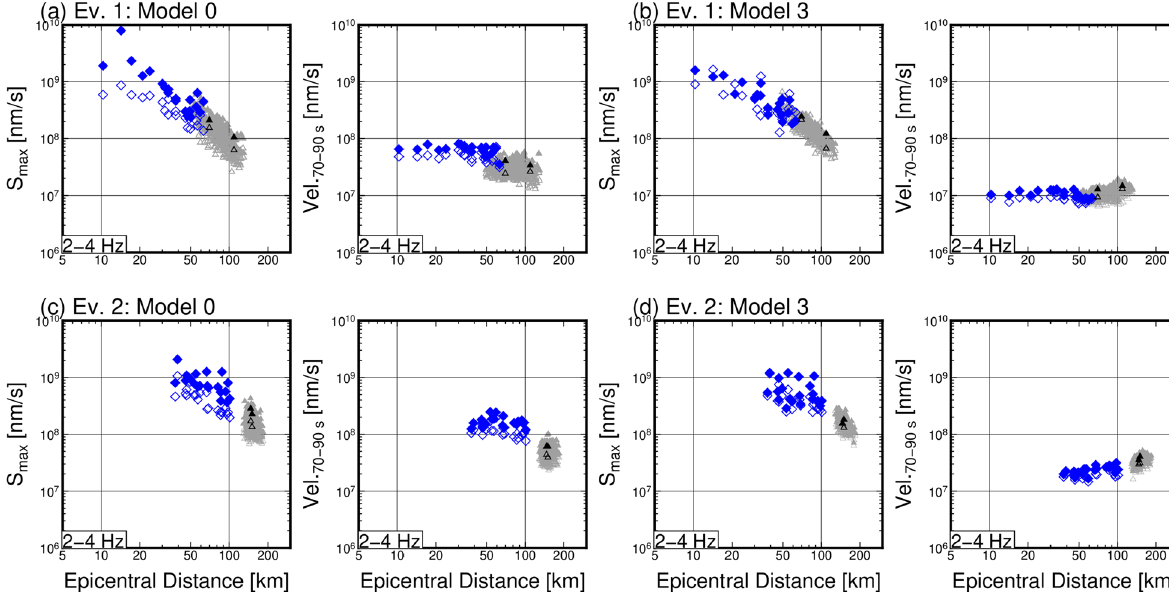
Fig. 9 S max and coda amplitudes for the frequency range 2.0–4.0 Hz as a function of epicentral distance. Plotted simulated amplitudes of Event 1 for a Model 0 and b Model 3 and of Event 2 for c Model 0 and d Model 3. The filled blue and open diamonds are horizontal and vertical amplitudes at DONET stations, respectively. The filled and open triangles are those at inland F-net stations. To increase the data of inland stations, we also evaluated simulated amplitudes at inland virtual seismic stations at an interval of 0.05° (gray